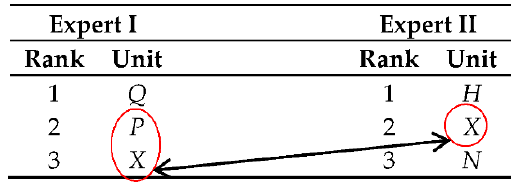
Figure 5. Ranking with multiple contradictions.